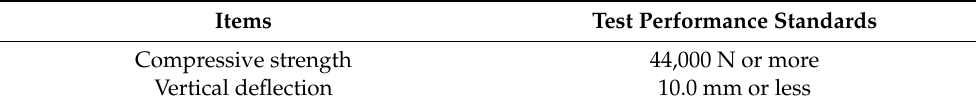
Table 7. Test performance standard for mobile scaffold